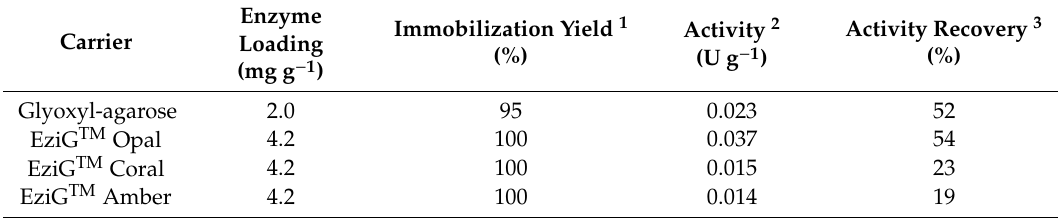
Table 1. Results of OYE3 immobilization.